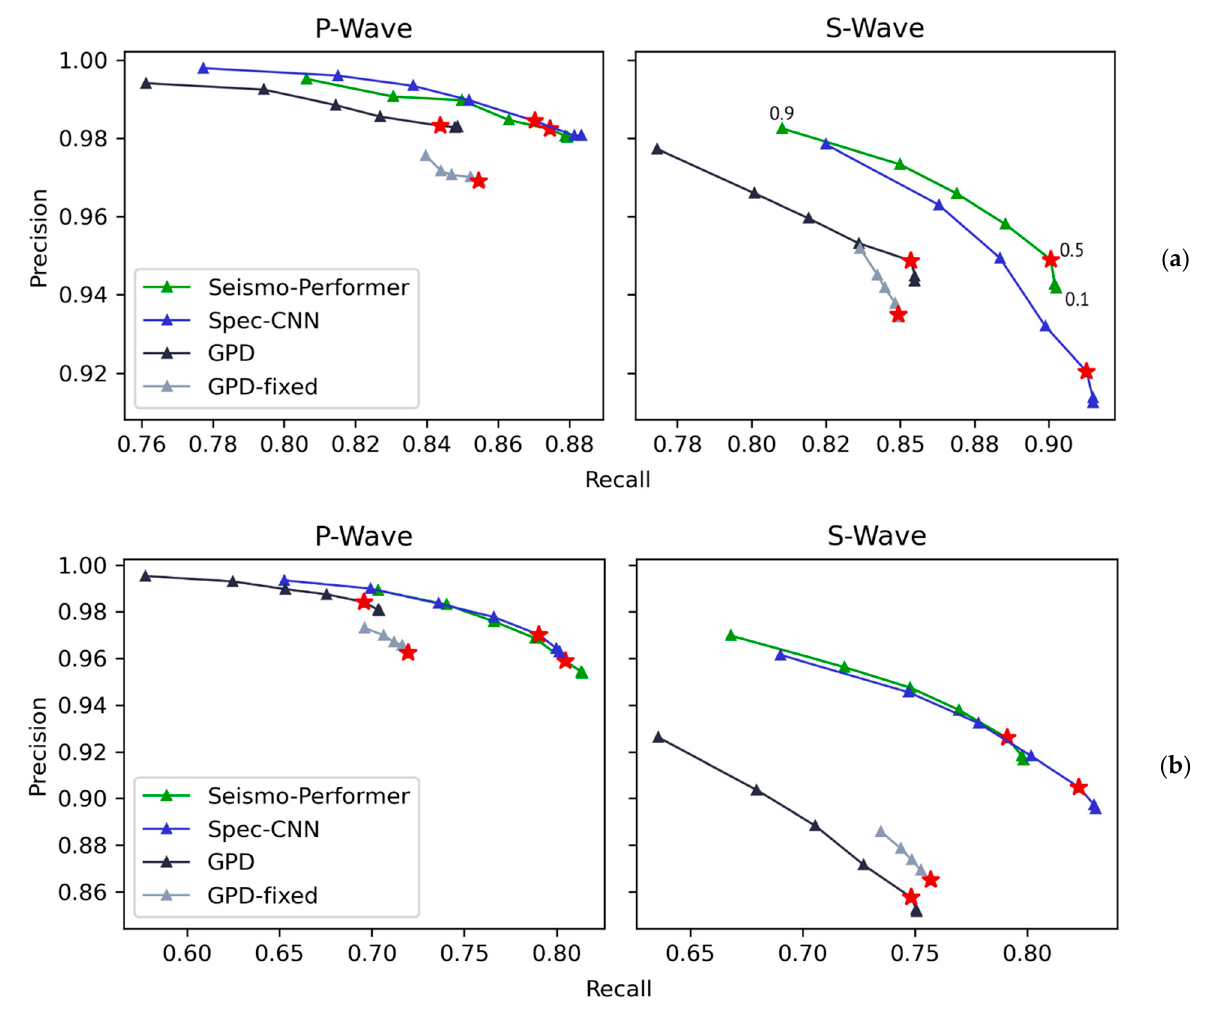
Figure 4. Precision/recall curves for the Seismo-Performer, Spec-CNN, and GPD classifiers on the Sakhalin ( a ) and Dagestan ( b ) datasets. The models were trained on the Southern California dataset only. Precision and recall were computed for different probability thresholds from 0.1 and 0.9 in increments of 0.1, resulting in nine precision and recall values for each classifier/dataset. Red stars show values for a probability threshold of 0.5.